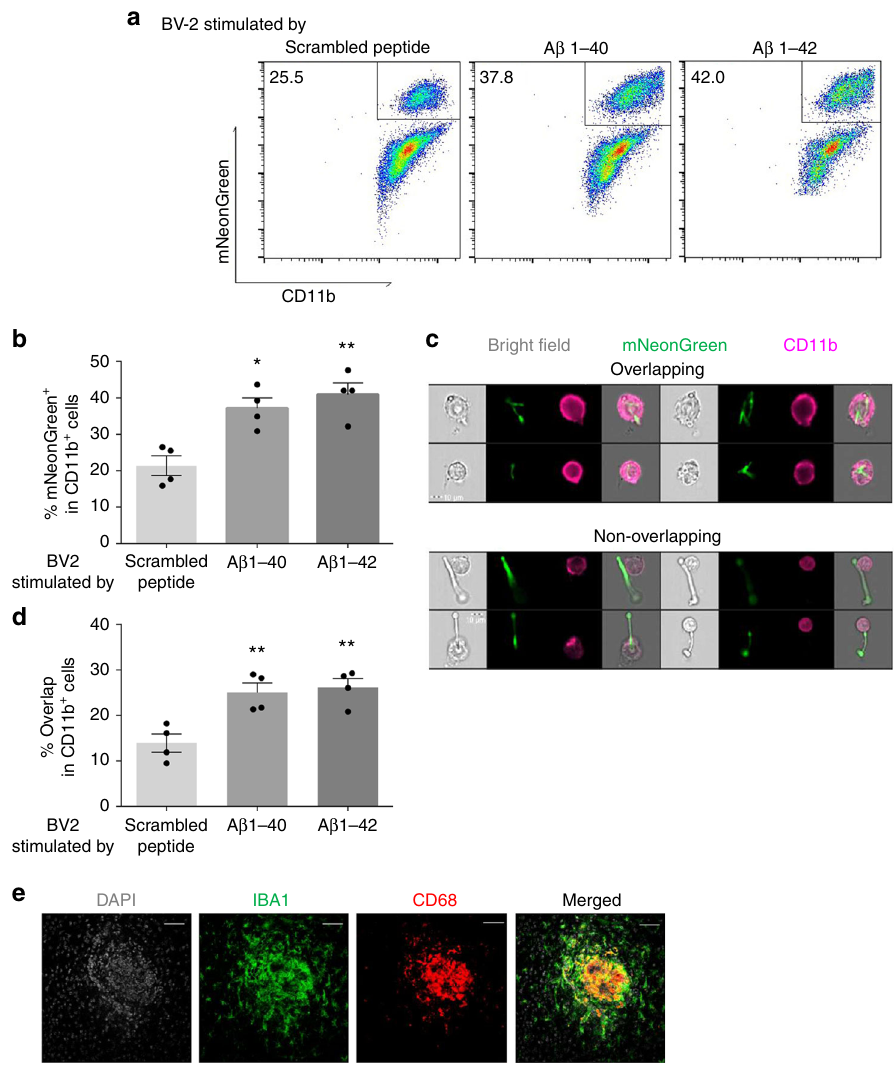
Fig. 6 A β peptides enhance phagocytosis by BV-2 cells. a Representative fl ow cytometry plot (ImageStream X) of A β − stimulated BV-2 cells co-cultured with mNeonGreen + Candida albicans . b Percentage of mNeonGreen + cells in all CD11b + cells. c Representative fl ow cytometry plots depicting overlapping and non-overlapping associations of yeast and CD11b + cells that distinguish cell – cell adherence from phagocytosis. d Percentage of overlap cells in all CD11b + cells. e Fluorescent microscopic images of a typical FIGG expressing CD68 + /IBA1 + microglia ( n = 4, mean ± S.E.M, * p < 0.05, ** p < 0.01 using one- way ANOVA followed by Dunnett ’ s test for multiple comparison. Data are shown as representative of two